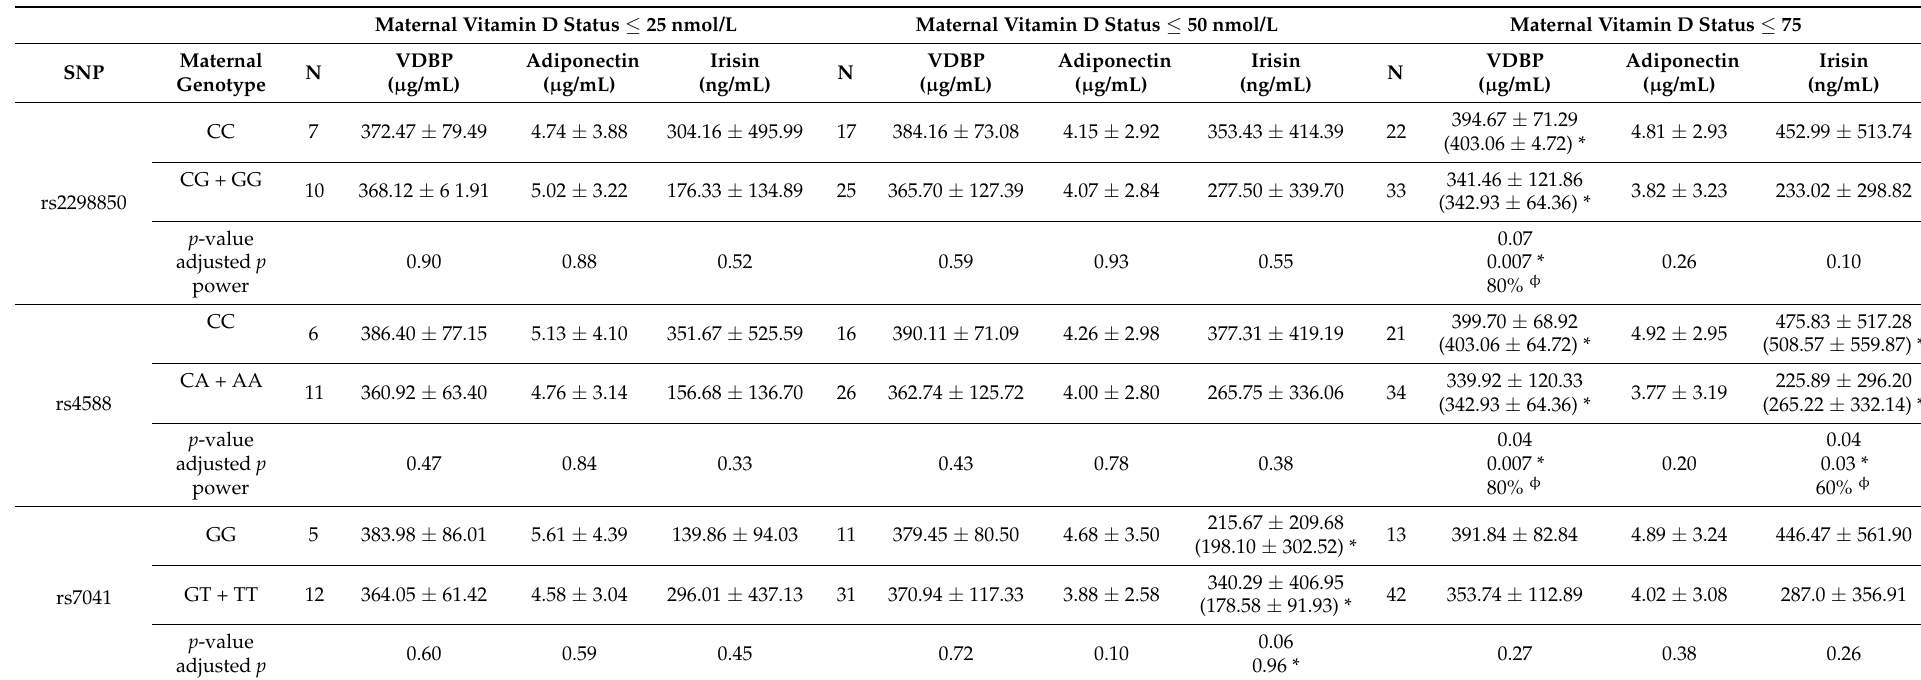
Table 4. Maternal serum biomarkers according to maternal vitamin D status and maternal VDBP